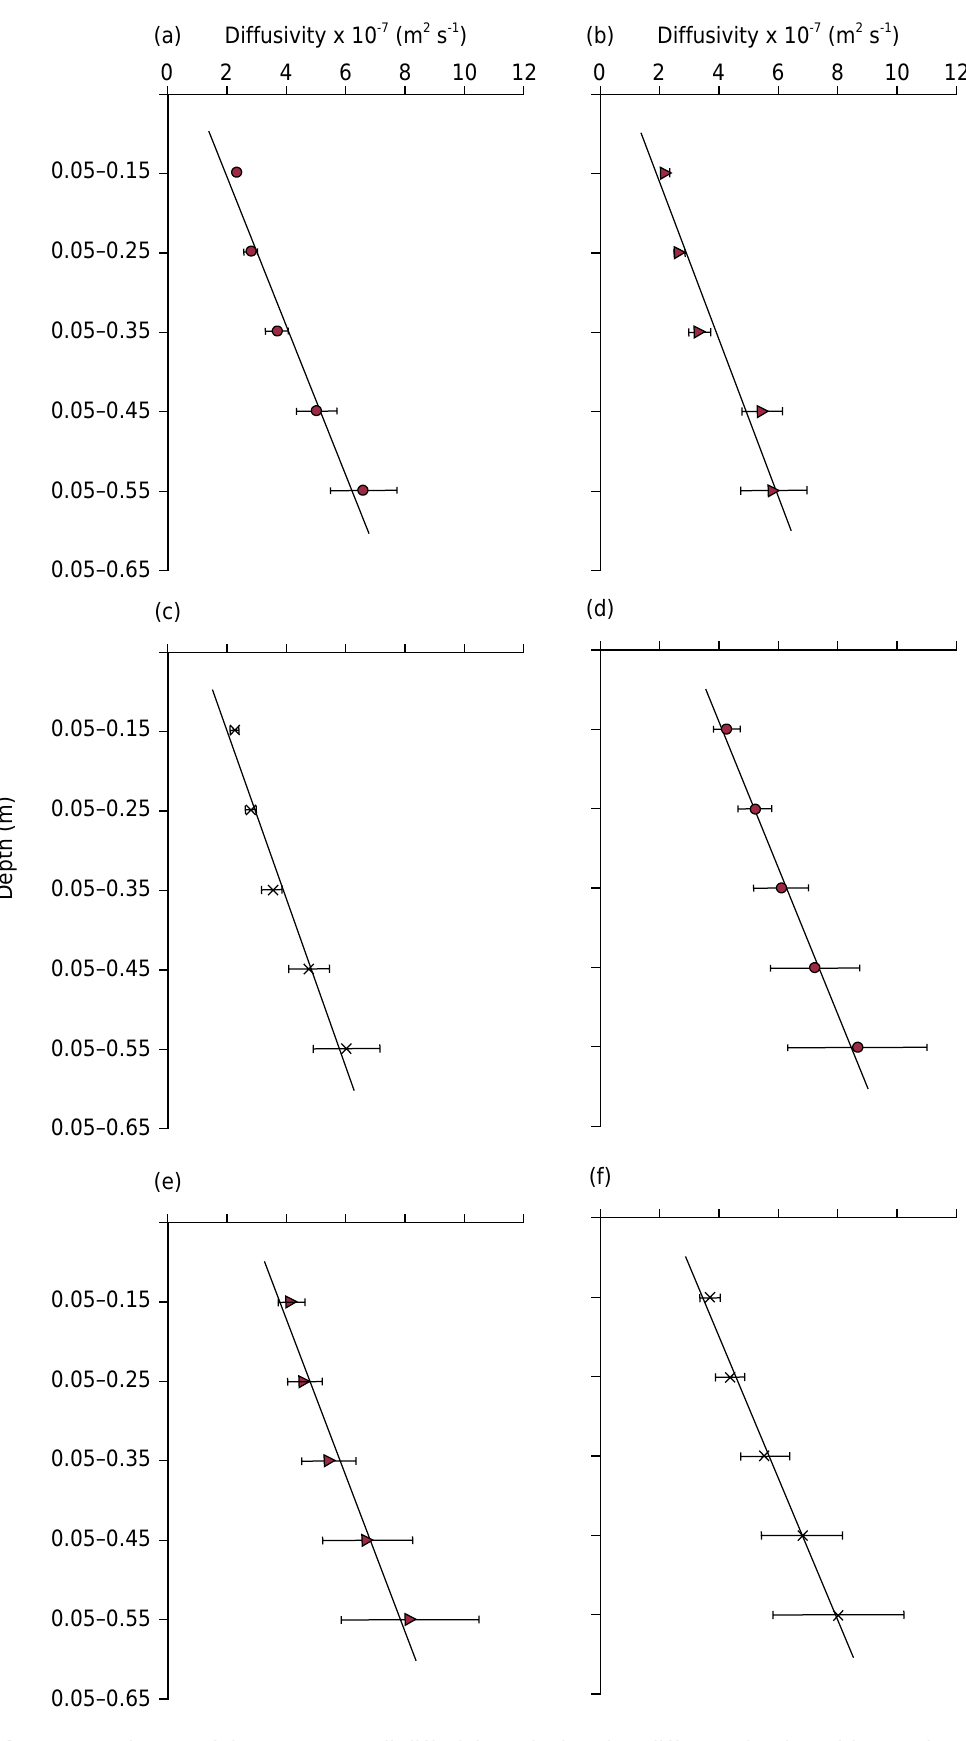
Figure 6. Columns of the apparent soil diffusivity calculated at different depths, with error bars and a straight line with a stochastic trend: (a) Period A, April 15; (b) Period B, April 16; (c) Period C, April 17; (d) Period D, August 7; (e) Period E, August 8; and (f) Period F, August 9,